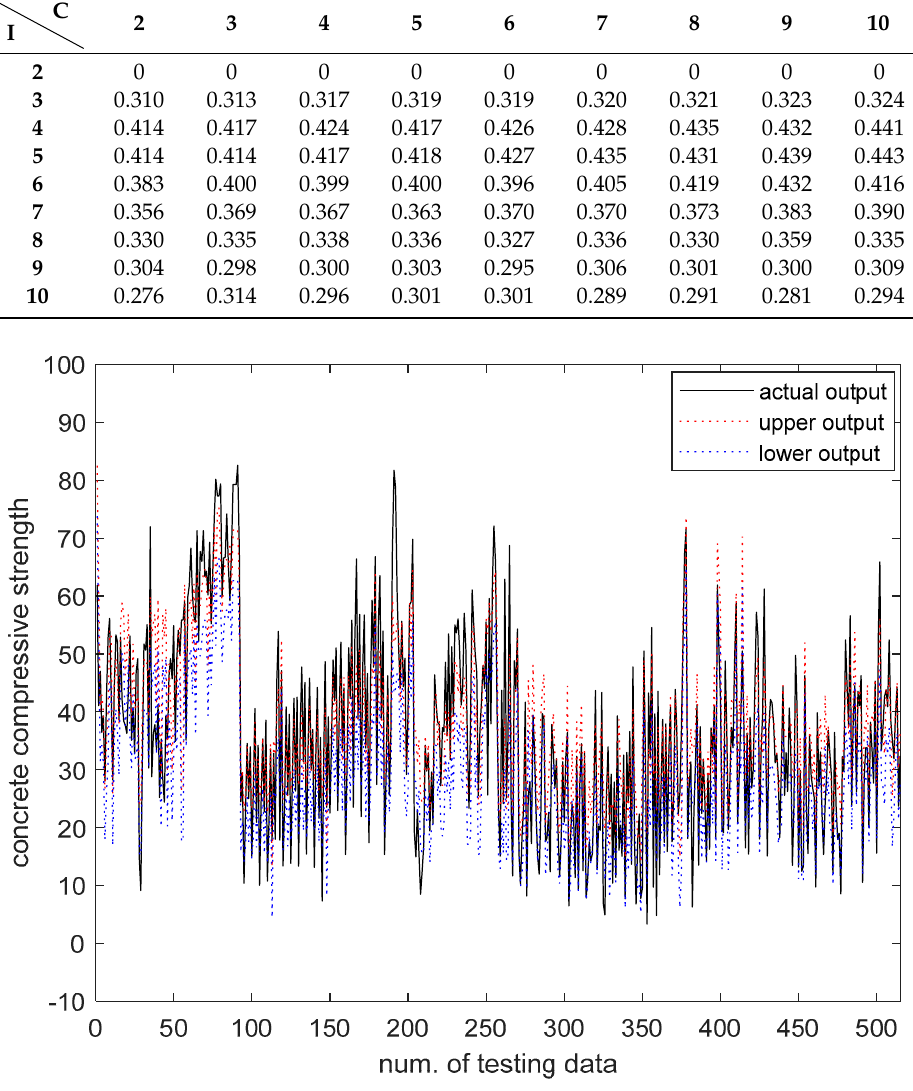
Figure 14. Prediction results for interval-based IGM (Case 3).